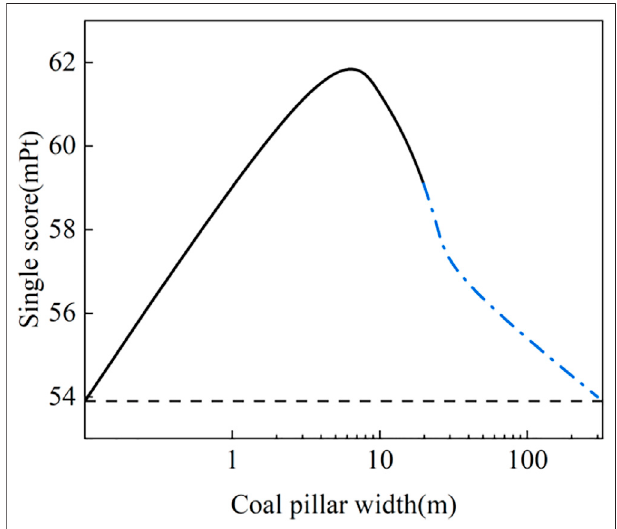
FIGURE 10 | Comparison of the single score for different mining